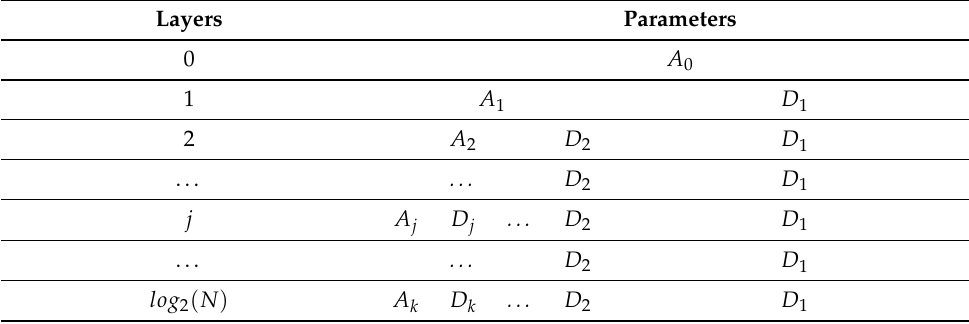
Table 1. Multilayer Harr wavelet